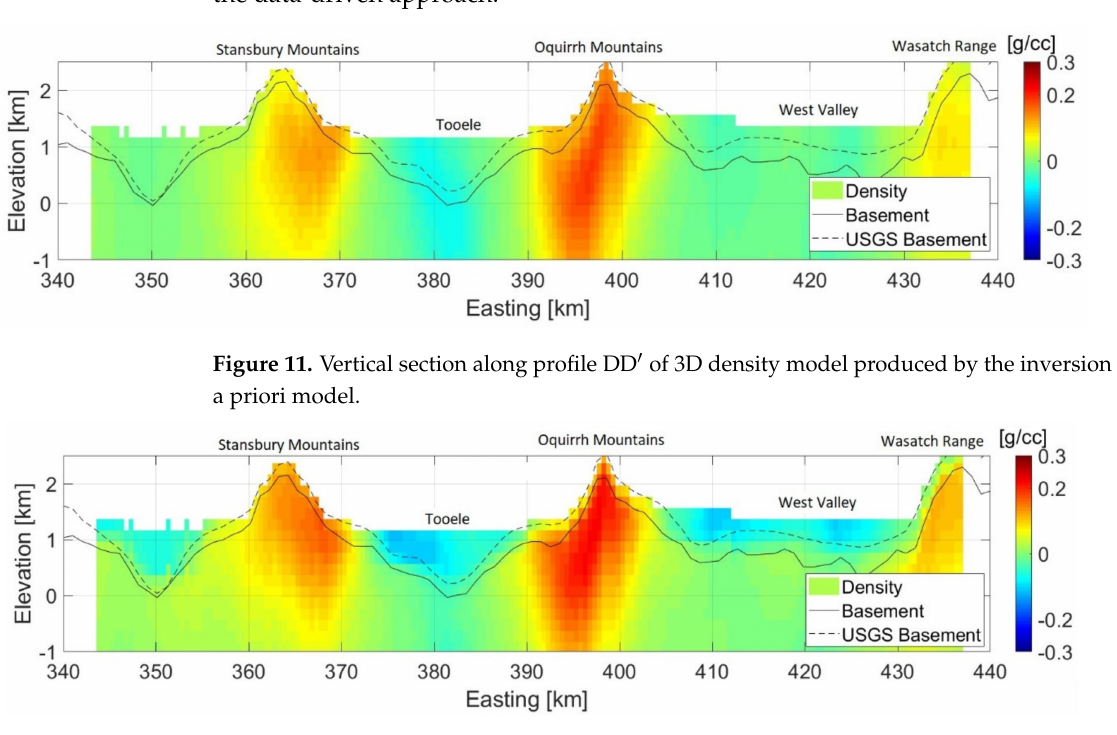
Figure 12. Vertical section along profile DD (cid:48) of 3D density model produced by the inversion with a priori density contrast